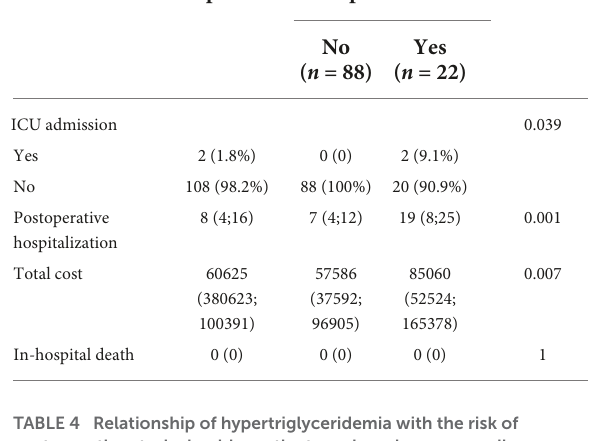
TABLE 4 Relationship of hypertriglyceridemia with the risk of postoperative stroke in older patients undergoing non-cardiac non-neurosurgery